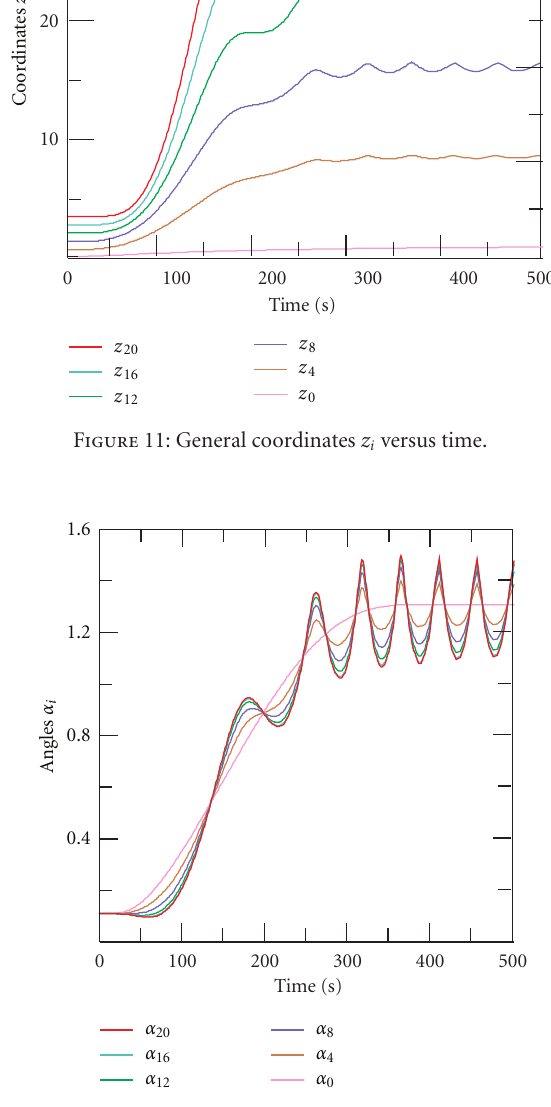
Figure 12: Time dependence of angles α i